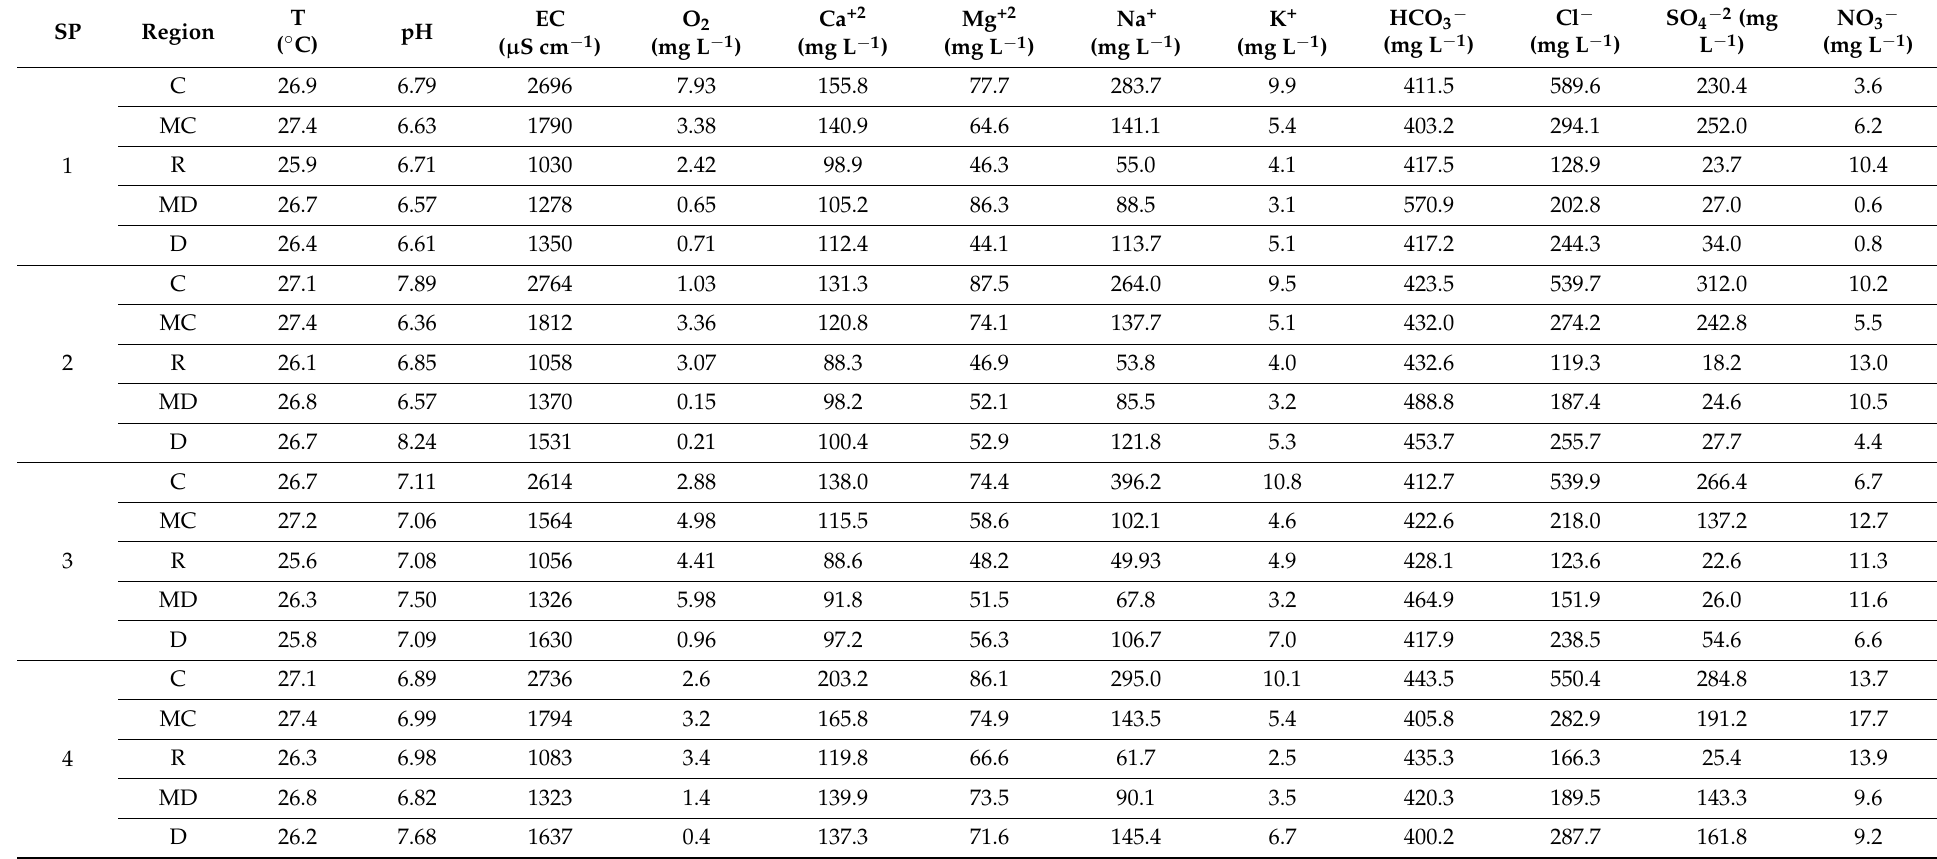
Table 1. Average concentrations for the representative samples. NO 3 − was excluded from the inverse modelling. Regions in this table were defined as the description in Figure 1. SP